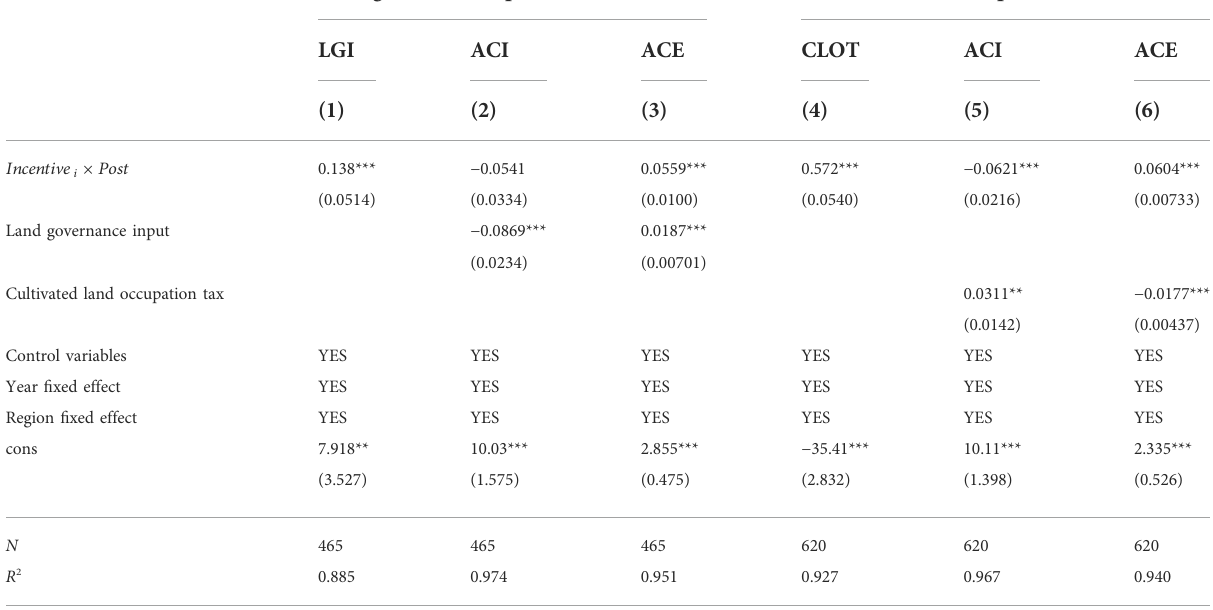
TABLE 7 Mechanism identi fi cation: administration